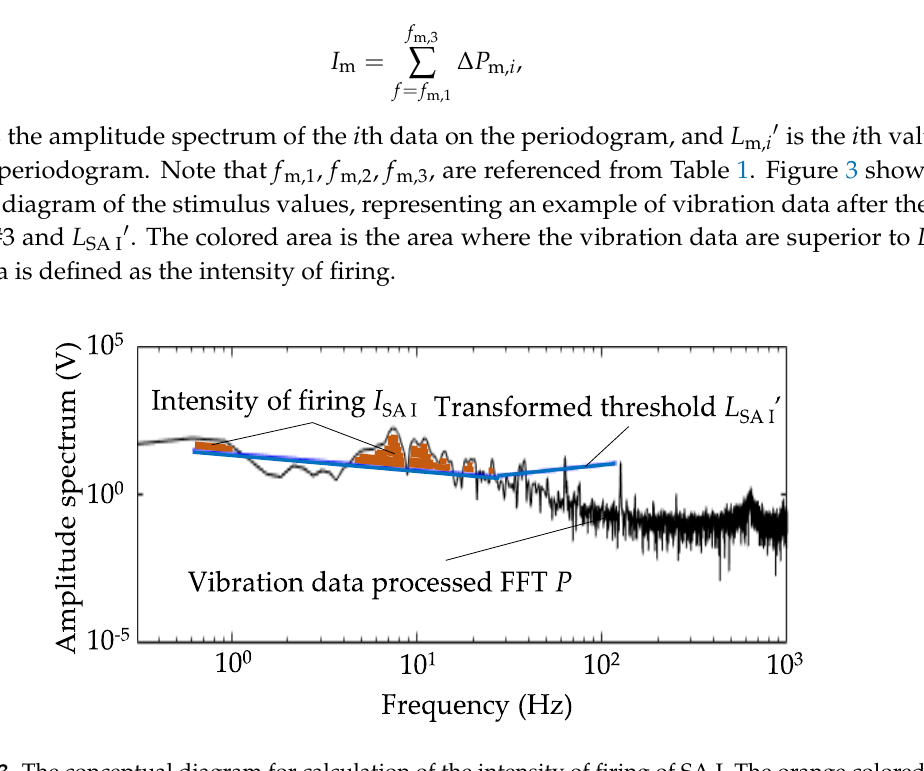
Figure 3. The conceptual diagram for calculation of the intensity of firing of SA I. The orange colored area between the vibration data and L SA I ’ corresponds to I SAI .